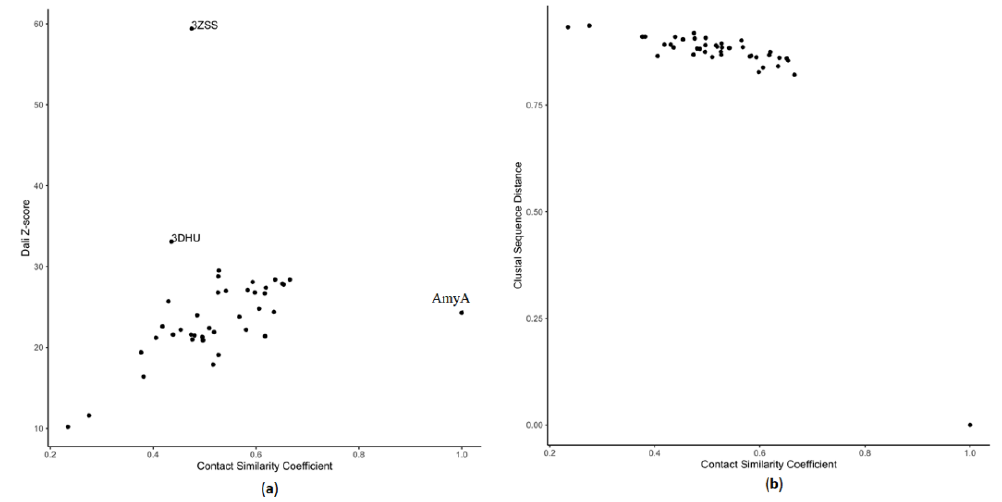
Figure 3. Parameters of similarity distance between evaluated enzymes and TmAmyA based on their correlation between contact conservation (R-squared) and ( a ) structure (Dali) and ( b ) sequence (Clustal) alignments.